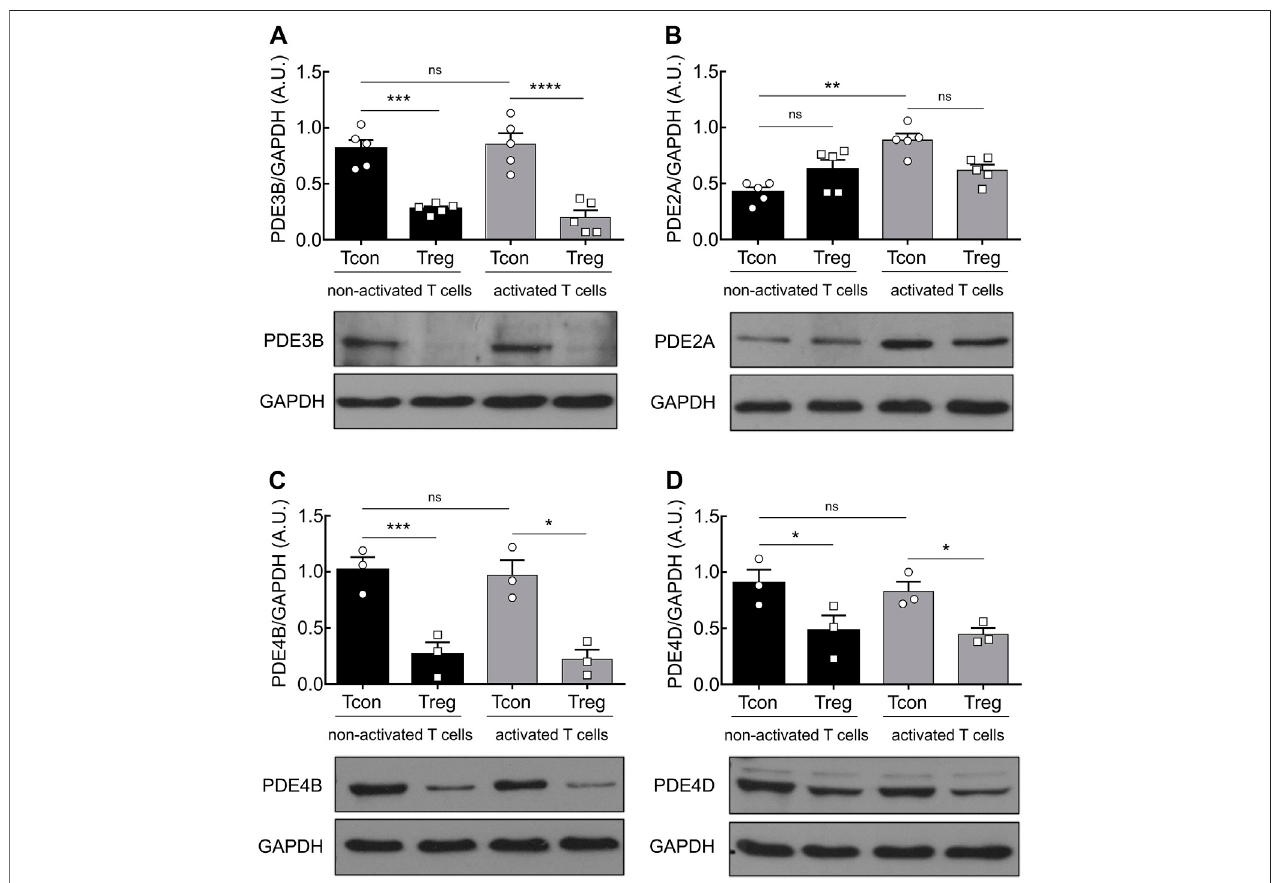
FIGURE 1 | PDE2A is upregulated in Tcon upon TCR engagement. Magnetically isolated T cell subsets were cultured for 24 h in the presence or absence of anti-CD3/CD28 Dynabeads. Representative immunoblots show protein expression and quanti fi cation of (A) PDE3B, (B) PDE2A, (C) PDE4B, and (D) PDE4D. GAPDH wasusedasaloadingcontrol.Resultsinbargraphsarepresentedasmean ± SEMfromthreeto fi veindependentexperiments.A.U. – arbitraryunit.* p < 0.05,** p < 0.01, *** p < 0.001, **** p < 0.0001, ns – not signi fi cant by one-way ANOVA followed by Sidak ’ s multiple comparison test.